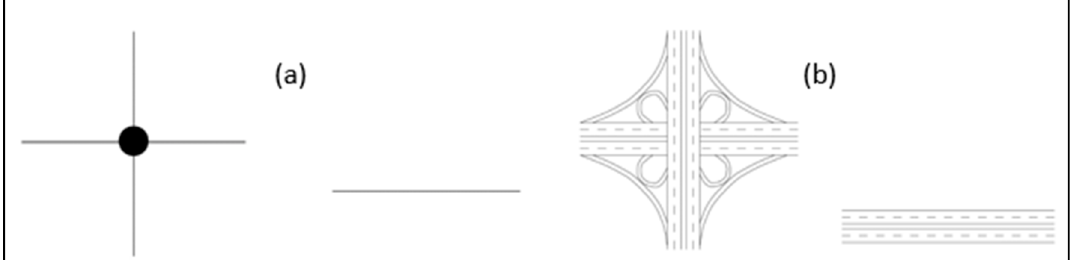
Figure 1. Representation of a highway interstate interchange (left) and the highway (right) at different scales (coarse scale in ( a ) and fine-grained scale in ( b )) (adapted from [41]).